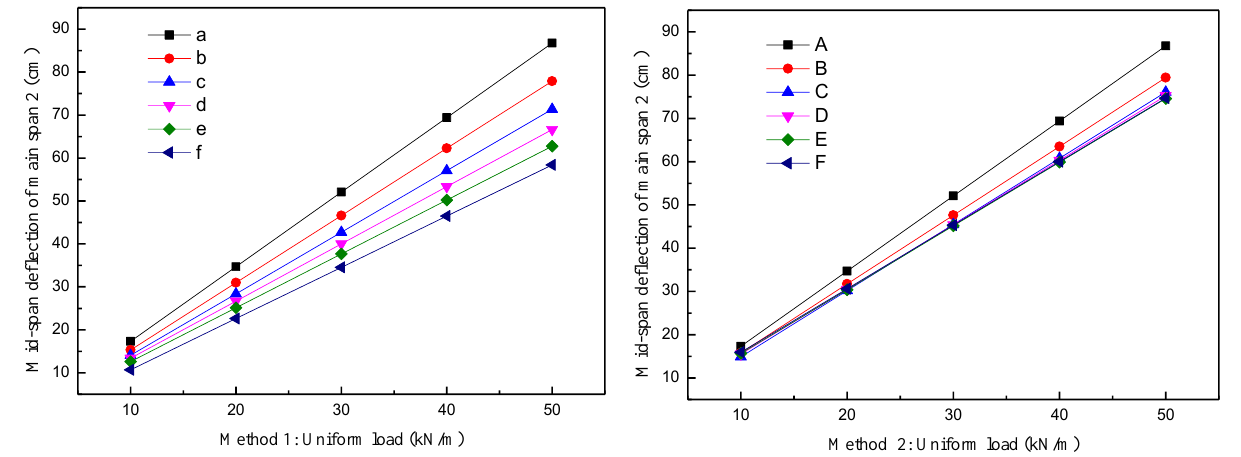
Figure 5. Comparison of deflection of main span.